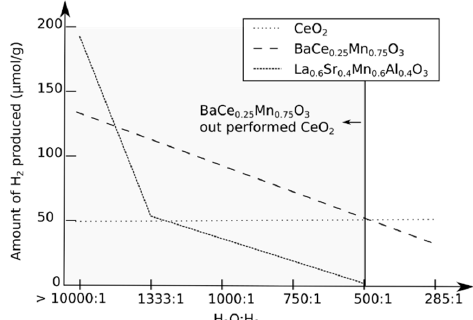
Figure 8. H 2 production as function of the H 2 O:H 2 ratio for La 0.6 Sr 0.4 Mn 0.6 Al 0.4 O 3 , BaCe 0.25 Mn 0.75 O 3 , and ceria at T red = 1350 °C and T ox = 850 °C (adapted from Reference [67]).